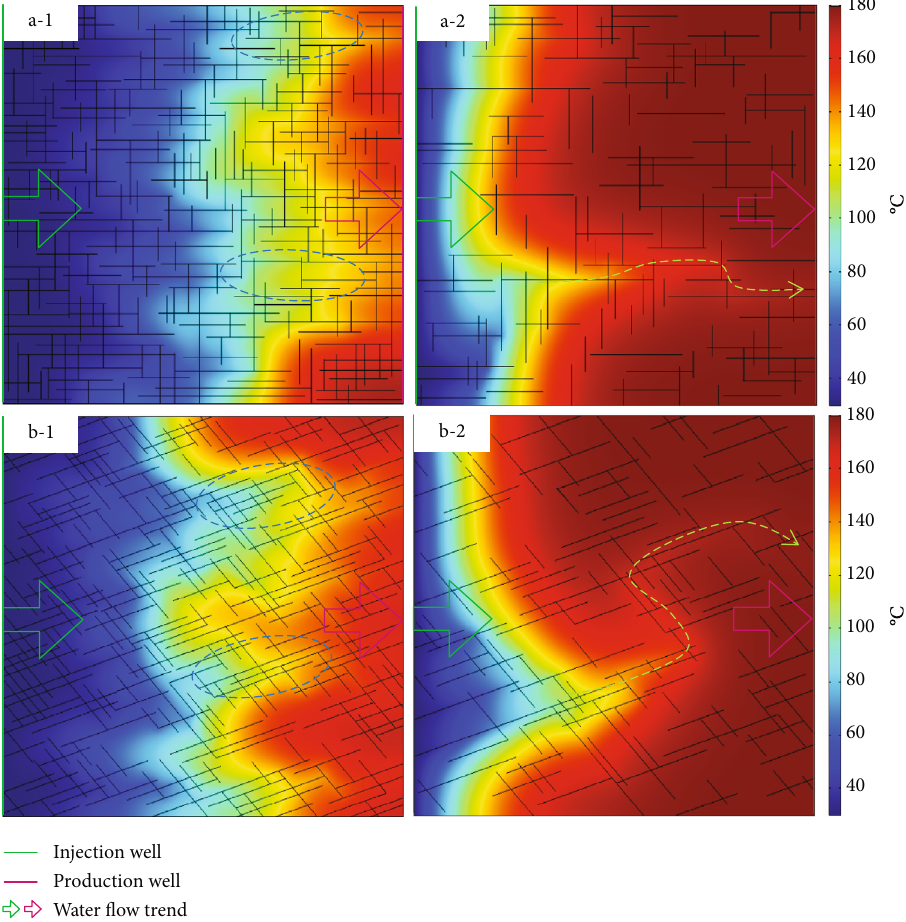
Figure 8: Temperature distributions of the four fracture networks at the 30th